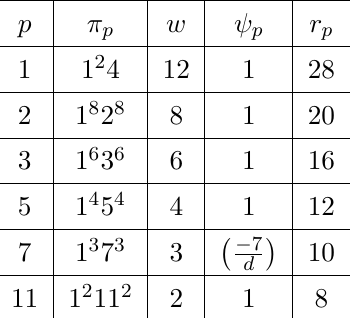
Table 1 . The prime- p CHL models. For each model, we give the order p of the orbifold, the frameshape (cid:25) p of the model, and the weight w and multiplier system p of (cid:17) g under (cid:0) 0 ( N ) trans- formations. The multiplier systems are given in terms of the Jacobi symbols de(cid:12)ned in eq. (2.16). For later reference, we also give the rank r p of the gauge group, computed using eq. (2.9). The information contained in this table is adapted from [36, 38, 39, 44,